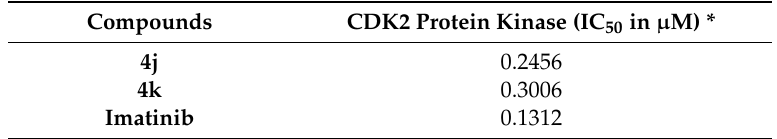
Table 2. Inhibitory activities of compounds 4j and 4k against CDK2 protein kinase.